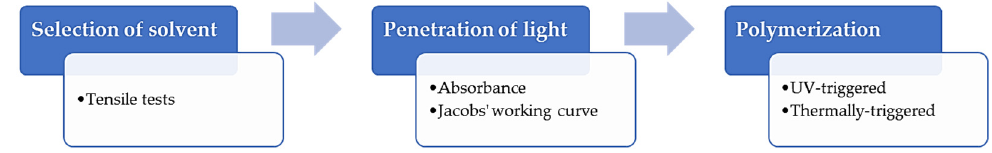
Figure 2. Experimental